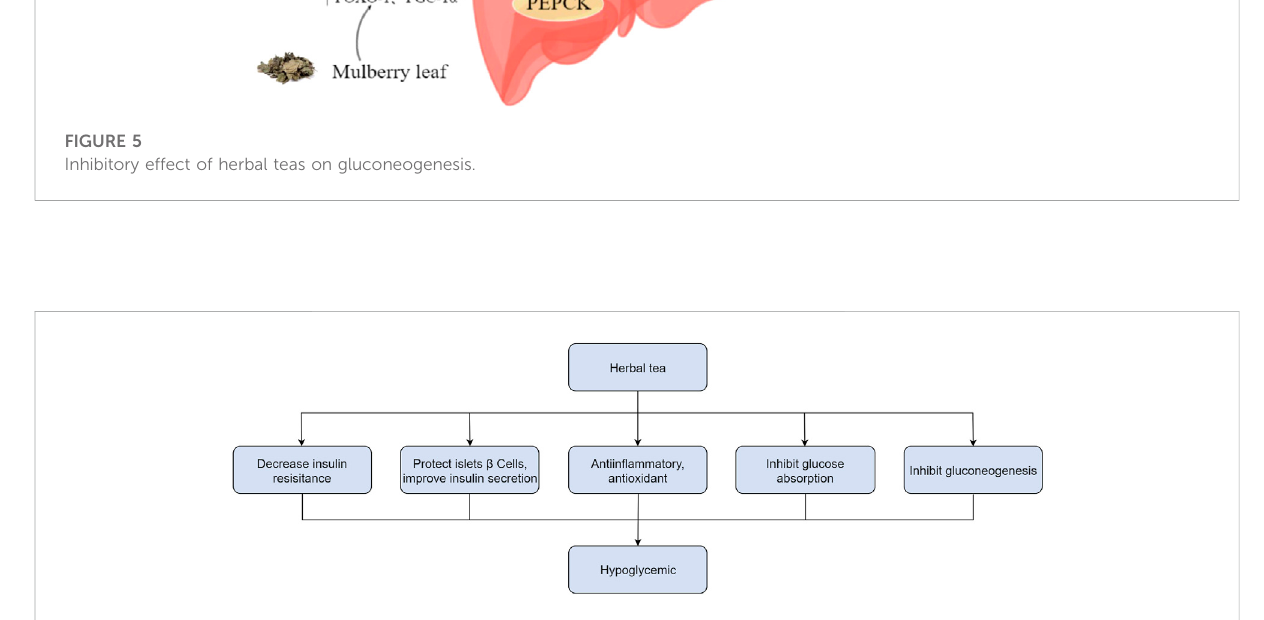
FIGURE 6 The effect of herbal teas in type 2 diabetes